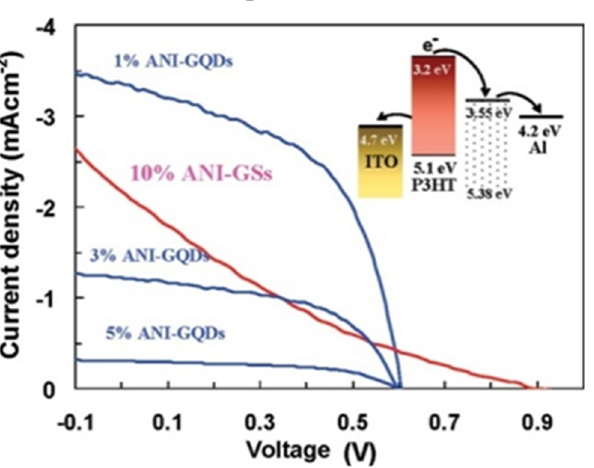
Figure 8. J-V characteristics of the photovoltaic (PV) devices based on Aniline-functionalized GQDs (ANI-GQDs) with different GQDs content and ANI-graphene sheet (GS) (under optimized condition) annealed at 160 °C for 10 min, under AM 1.5 G 100 mW illumination. Reprinted with the permission of Reference [90]. Copyright 2011 American Chemical Society.